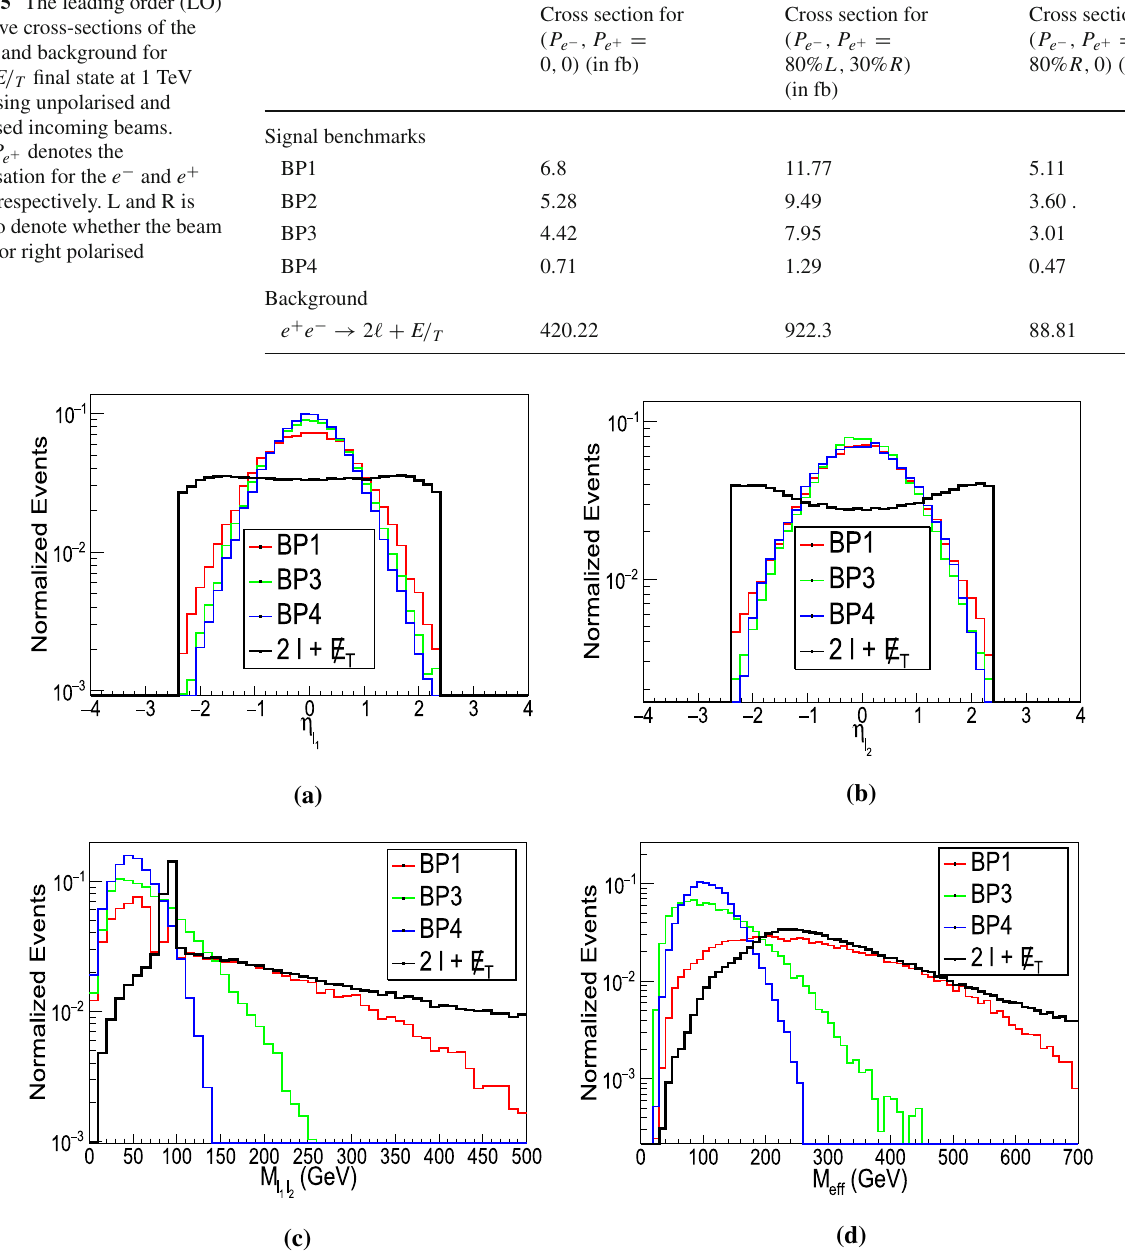
, η (cid:10) , M (cid:10) , M (cid:10) + E / T channel at 1 TeV ILC eff for 2 1 2 1 (cid:10) 2